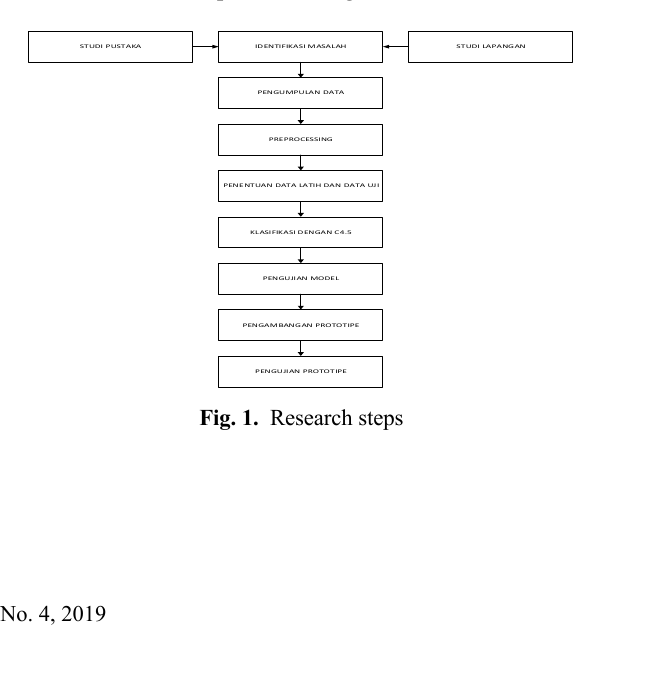
Paper —Application of Classification Algorithm C 4.5 for Predicting Asset